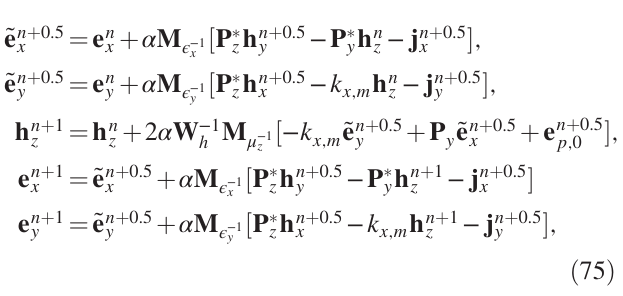
FIG. 7. For the Pohang dechirper: function W cc ð k